Question: Which visualization type does this figure use?
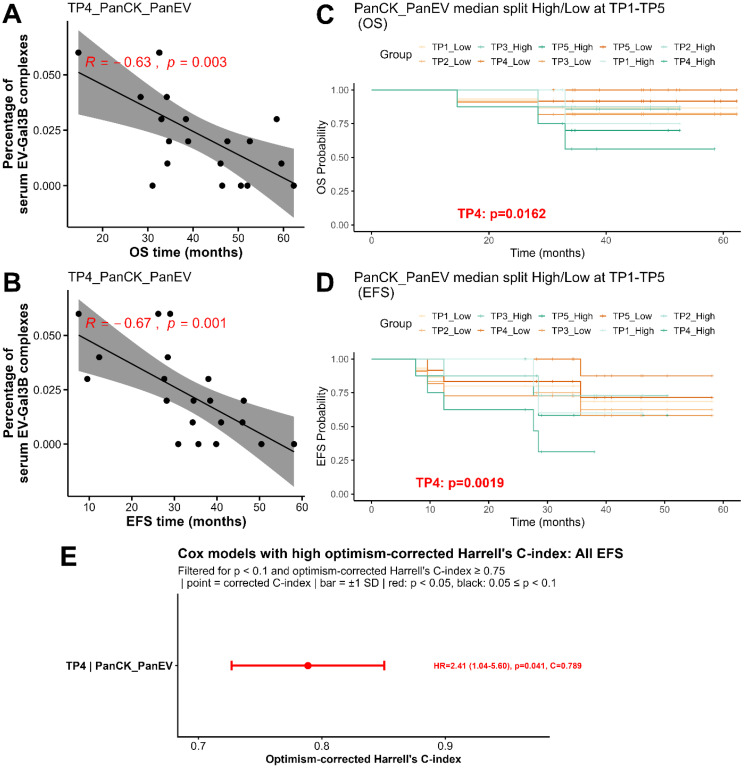
Answer: survival